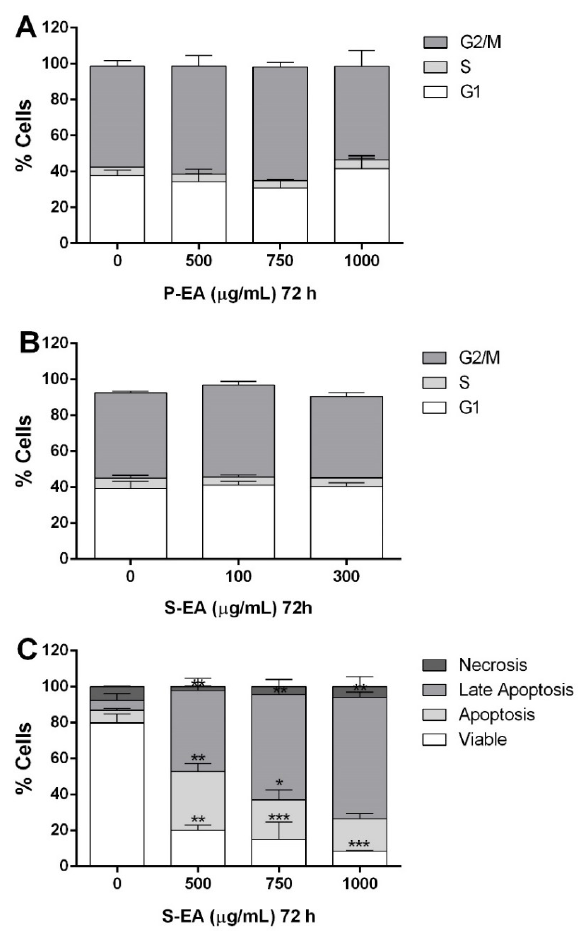
Figure 8. Analysis of the cell cycle progression of MCF7 cells after incubation with P-EA fraction ( A ) and S-EA fraction ( B ), and apoptosis induction after incubating with S-EA ( C ), using flow cytometry. For cell cycle, the cells were treated with P-EA (500, 750 or 1000 µg/mL) and S-EA (100 or 300 µg/mL) for 72 h. For analysis of apoptosis, the cells were treated with S-EA (500, 750 or 1000 µg/mL) for 72 h. Statistical analyses were performed by unpaired t -tests. The results represent the mean ± SD of two independent experiments ( n = 3). * p < 0.05; ** p < 0.01; *** p < 0.001 compared to vehicle group (control group).